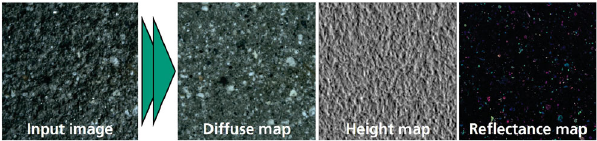
Fig. 4 Left: single example image from the ABTF dataset. Right: reference image components for patch transfer guidance based on optical error, derived from the entire ABTF dataset to represent surface structure and material